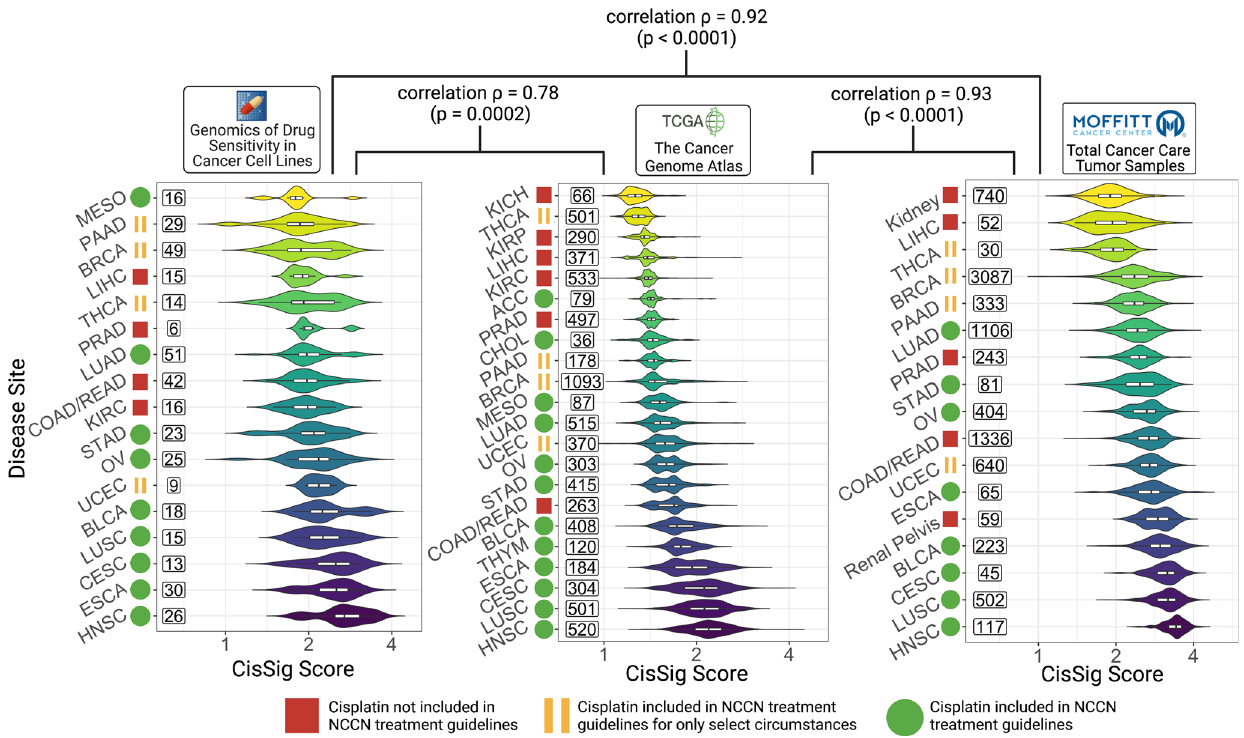
Fig. 5 Cancer subtypes with greater CisSig expression tend to have cisplatin included in standard of care guidelines. Cancer subtypes are ranked by median CisSig Score in three datasets, GDSC (left), TCGA (middle), and TCC (right). The color of each violin plot represents the rank of the cancer subtype. The ranks of intersecting subtypes between each dataset are compared with Spearman ’ s rank correlation, reported with correlation ρ and p -value. Rank correlation ρ between GDSC and TCGA and GDSC and TCC datasets is 0.78 ( p = 0.0002) and 0.92 ( p < 0.0001), respectively. Rank correlation r between TCGA and TCC datasets is 0.93 ( p < 0.0001). Violin plots display the distribution of CisSig scores for each cancer subtype. Within each violin, a boxplot denotes median signature score for each subtype (middle horizontal line) and 25th/75th percentile for signature scores (box edges). Numbers to the left of each violin plot represent sample size included in each cancer subtype. For disease sites labeled as using cisplatin in select circumstances, notes about these circumstances are included in Supplementary Table 8. Created with